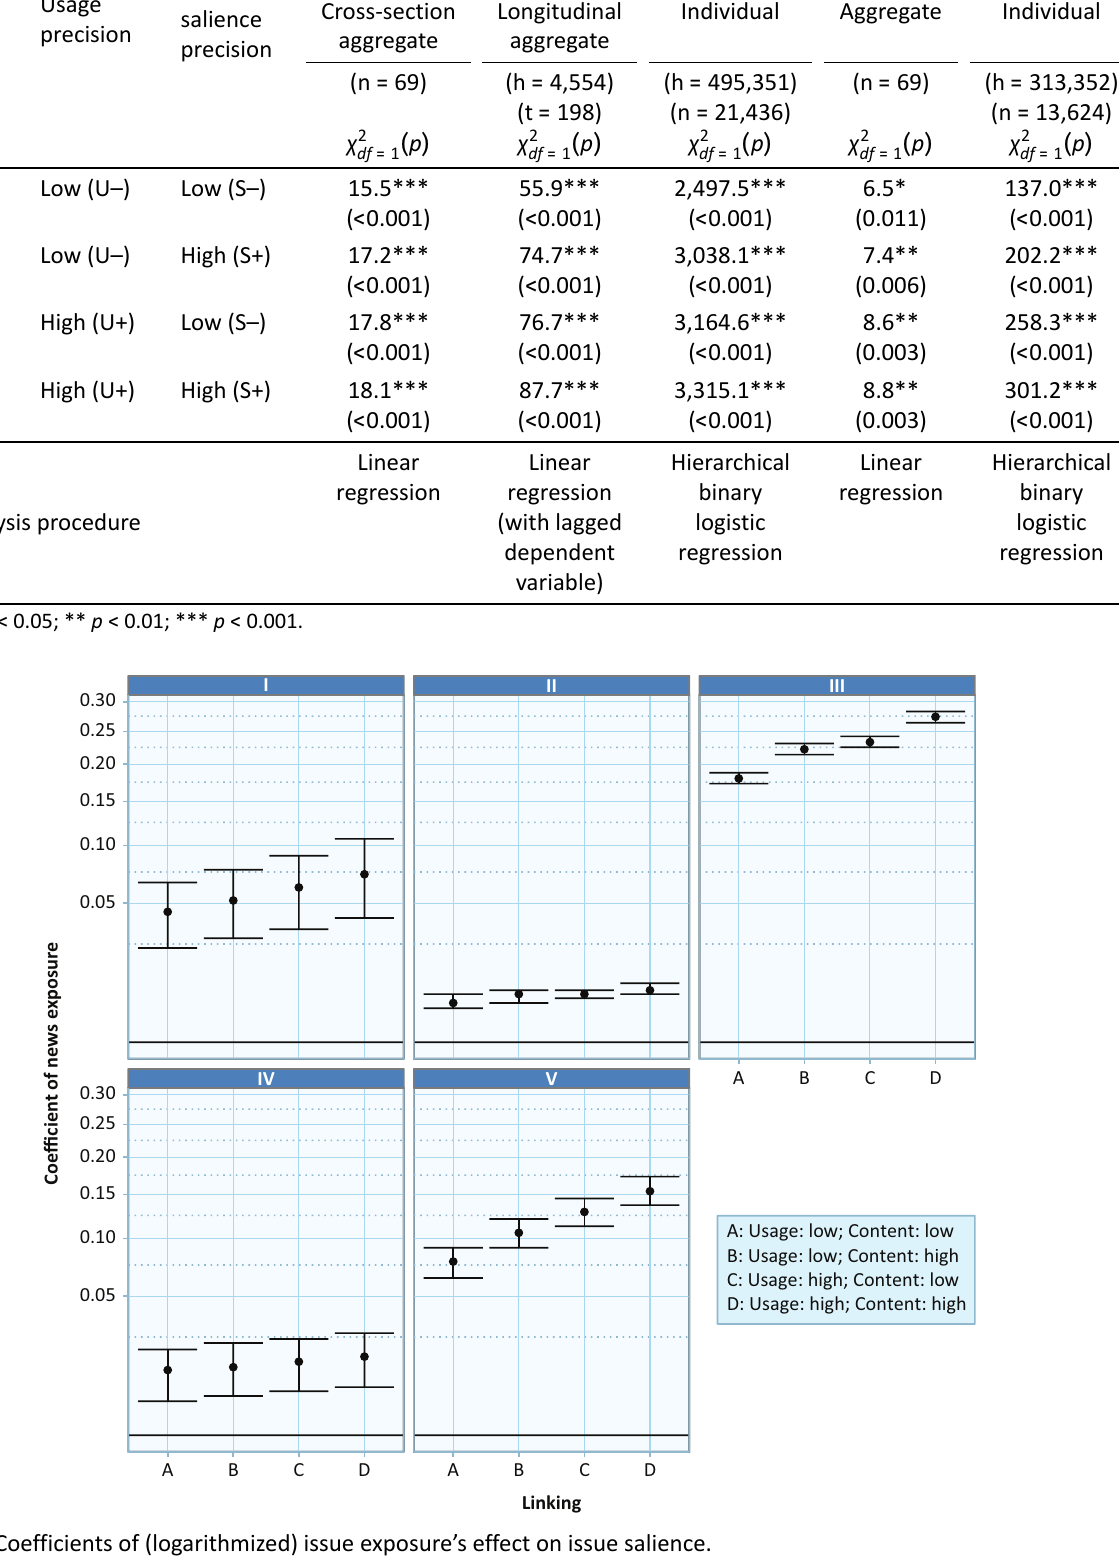
Figure 1. Coefficients of (logarithmized) issue exposure’s effect on issue